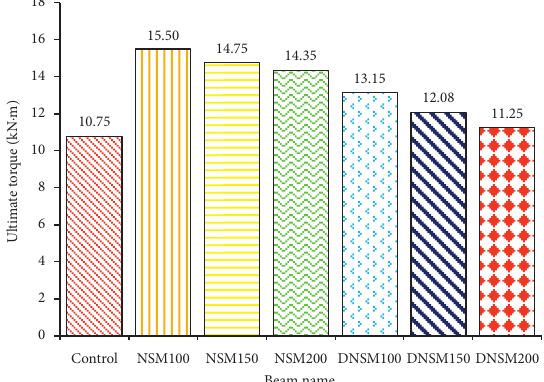
Figure 10: Ultimate torsional moment carrying capacities of the beam specimens.